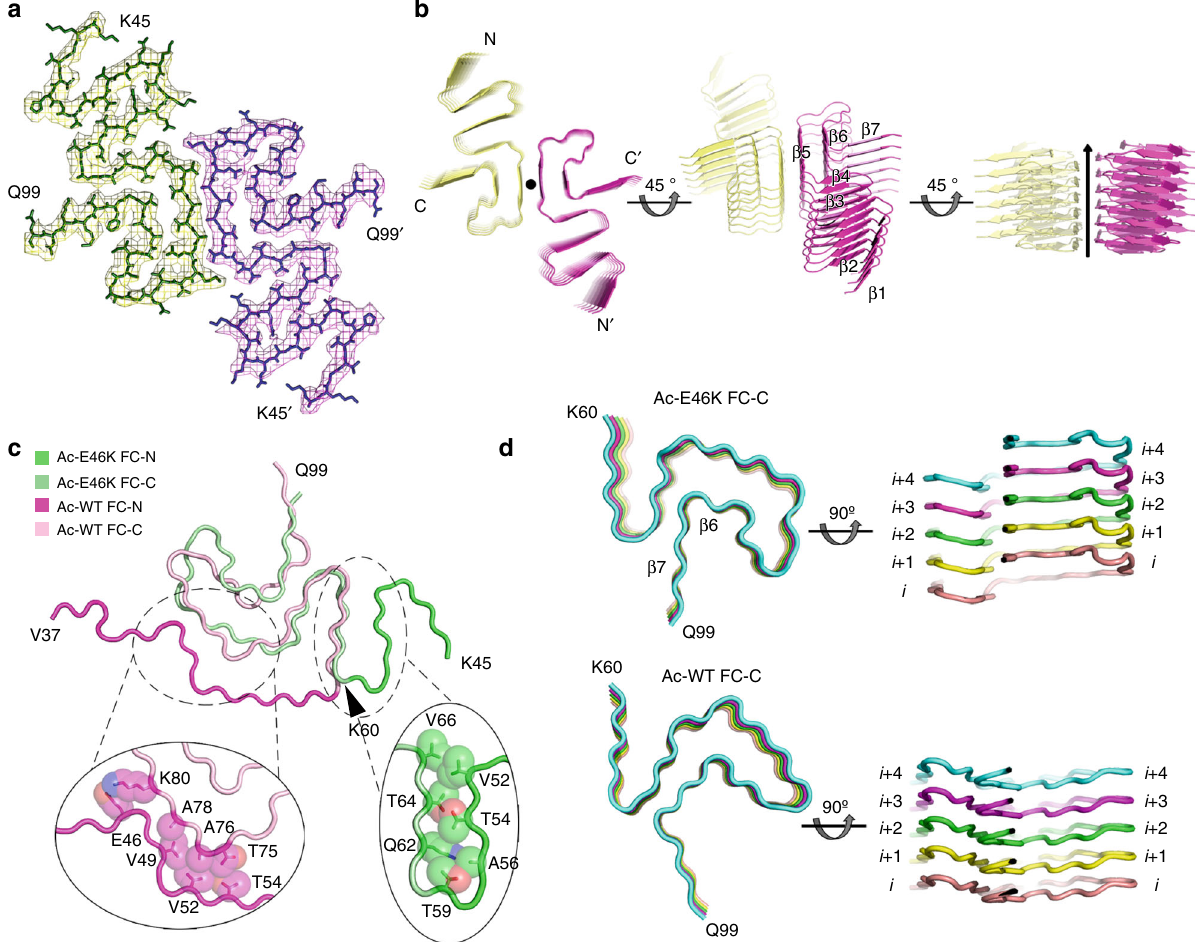
Fig. 3 Cryo-EM structure of the Ac-E46K α -syn fi bril. a Top view of the Ac-E46K fi bril. One layer of the structure is shown, which consists of two α -syn molecules covering residues 45 – 99. The two molecules are colored differently. b Views of six layers of the Ac-E46K fi bril are shown in cartoon. The two proto fi laments are colored differently. The fi bril axis is indicated. The β strands are numbered and labeled. c Overlay of the α -syn subunit structures of the Ac-E46K and Ac-WT fi brils. The two structures diverge mainly at the FC-N region. The interfaces between the FC-N and FC-C regions are shown in the zoom-in views. The residues involved in the interfaces are labeled and their side chains are shown in spheres. d Comparison of the FC-C region of the Ac- E46K and Ac-WT fi brils. Five layers of a single proto fi lament is shown. The structures are colored by different layers. The FC-C region adopts similar topology in the two structures, while their structural arrangements in the two fi brils are markedly different. The FC-C of the Ac-WT fi bril folds in a fl at layer. In contrast, in the Ac-E46K fi bril, β 6 and β 7 swap to the next α -syn molecule in the neighboring